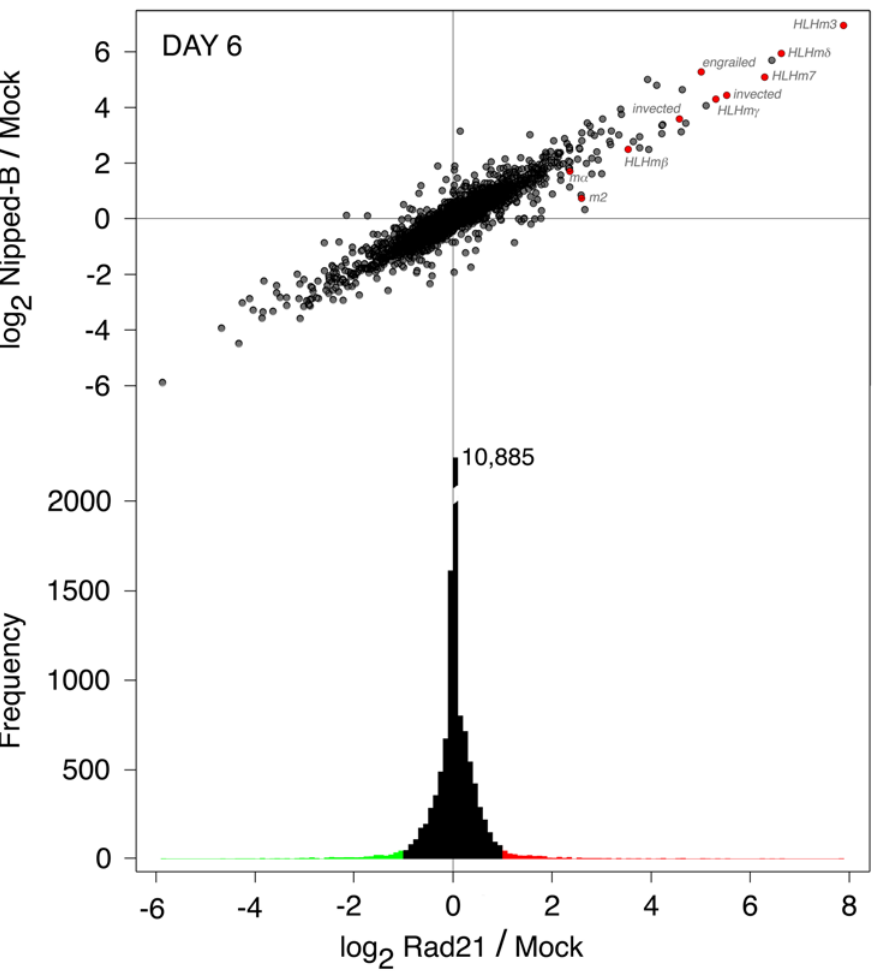
Figure 7. Genome-wide effects of Rad21 and Nipped-B RNAi on RNA transcripts in BG3 cells. The top graph shows the effects of Rad21 knockdown on transcript levels (log 2 Rad21/Mock) versus the effects of Nipped-B knockdown (log 2 Nipped-B/Mock), 6 days after RNAi for all 18,770 probes on the microarray. E(spl)-C and invected-engrailed transcripts are red. The bottom is an aligned histogram of the effects of Rad21 RNAi, with transcripts that increase 2-fold or more in expression in red, and transcripts that decrease 2-fold or more in green.